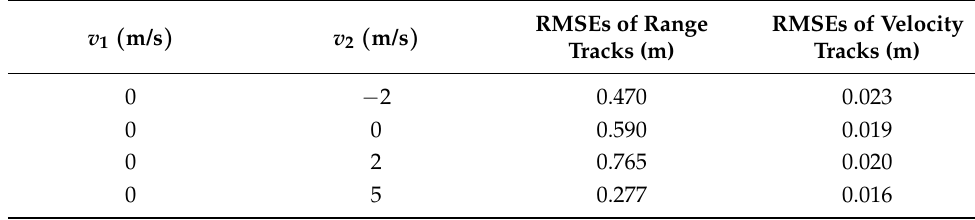
Table 2. The RMSEs of range and velocity